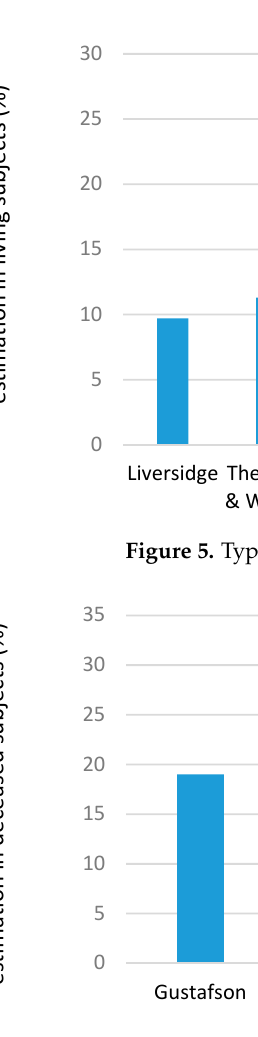
Figure 6. Types of methods used for age estimation in the deceased (%).